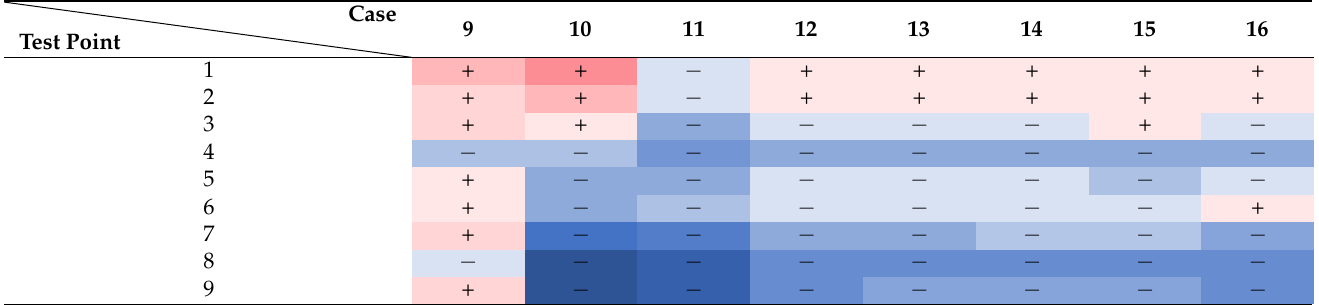
Table 5. The results of temperature change at different points in cases 9–16.